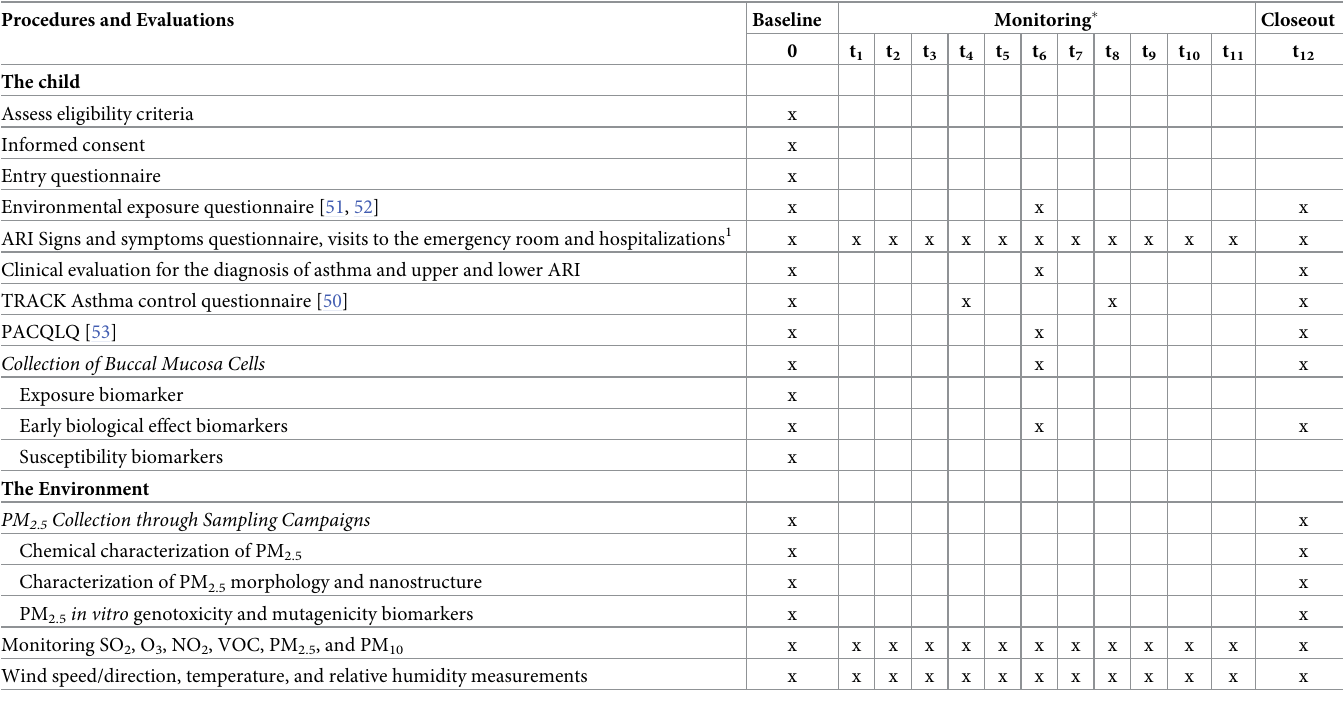
Table 2. Scheduling of PROMESA study procedures and